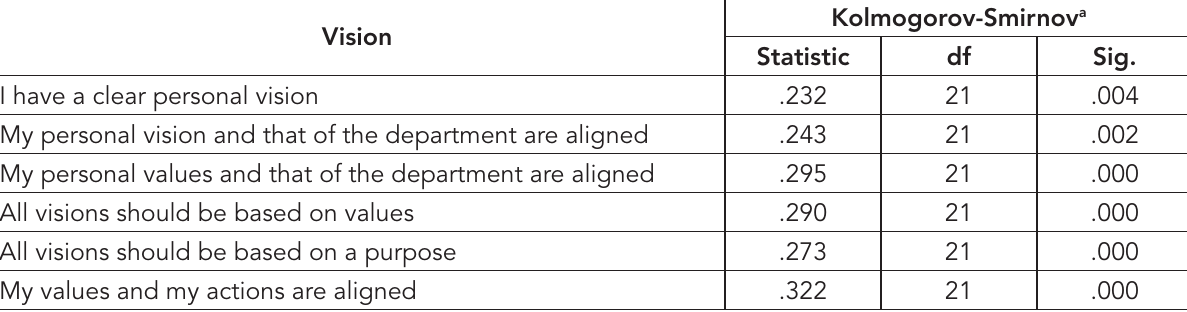
Table 8: Significance: Test of